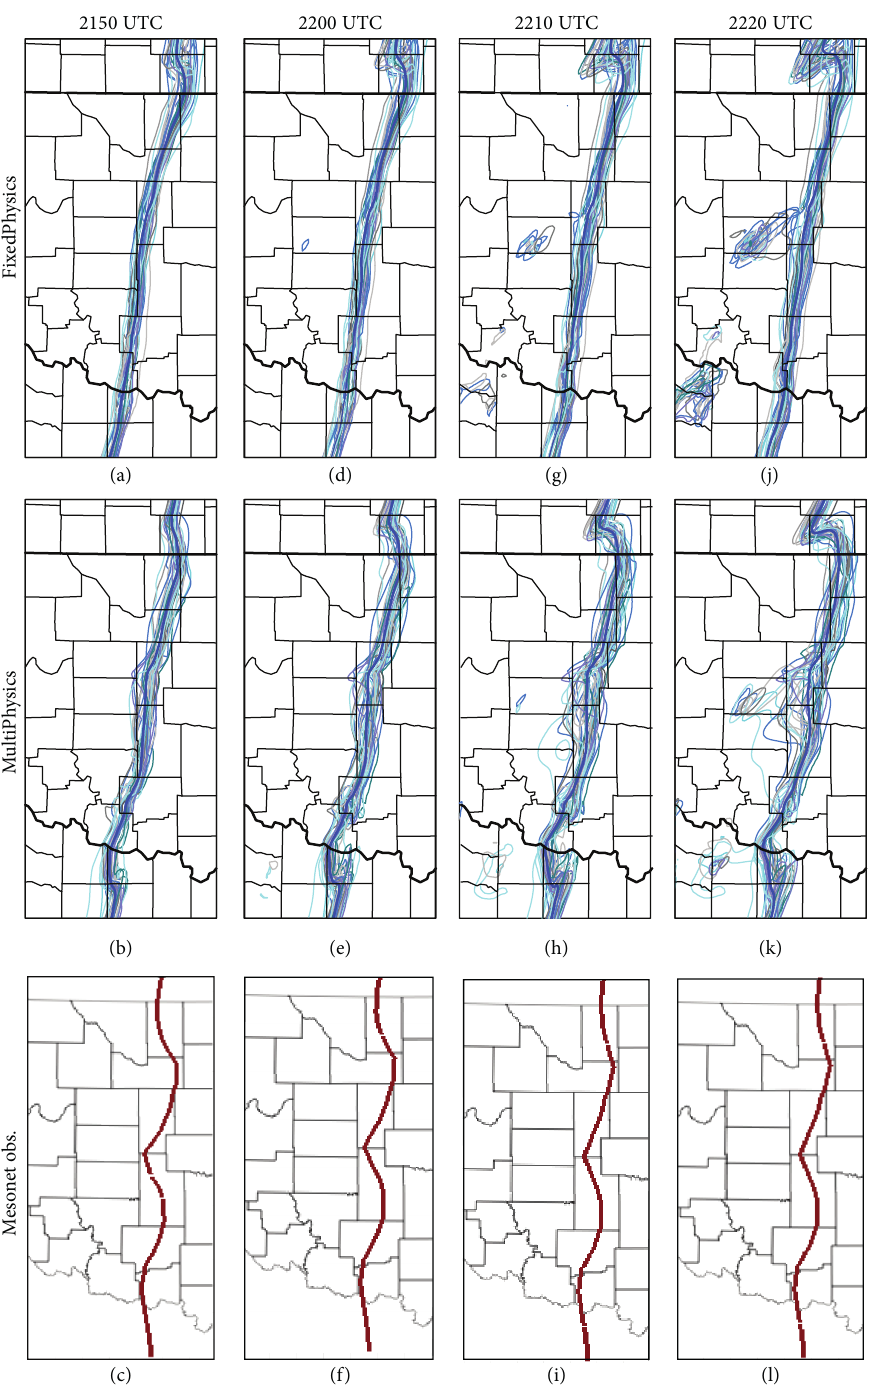
Figure 3: Isolines of 10 ∘ C 2m dewpoint temperature forecasts from FixedPhysics and MultiPhysics convective-scale ensemble members (thin blue lines), ensemble mean (thick blue lines), and Oklahoma mesonet observations (red line) at ((a), (b), (c)) 2150, ((d), (e), (f)) 2200, ((g), (h), (i)) 2210, and ((j), (k), (l)) 2220 UTC May 8, 2003. The portion of the domain shown here is 201 × 435 km wide.